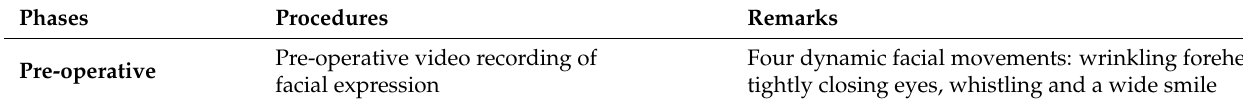
Table 1. Proposals for standardization of intraoperative FNM in parotid surgery.